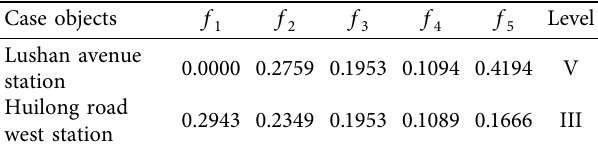
Table 9: The environmental risk levels of the two stations. Case